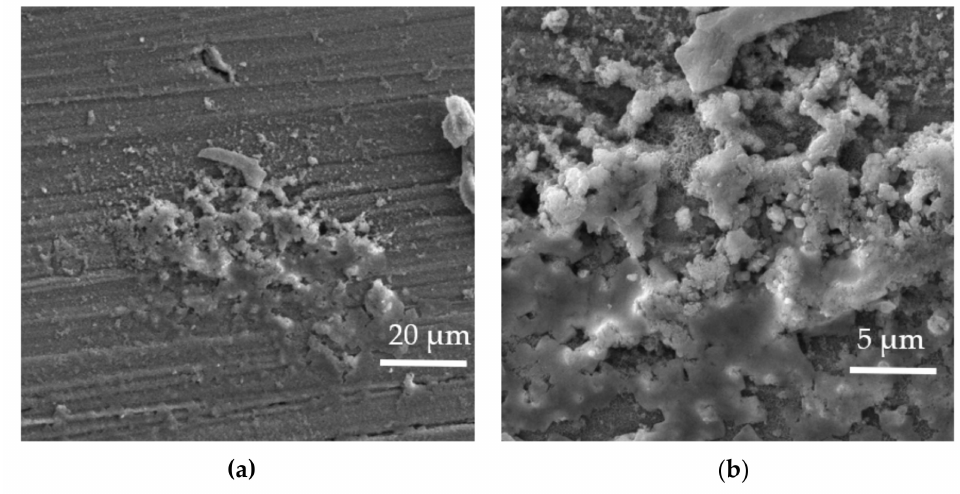
Figure 9. SEM images of PEO coating degradation in 0.1 M NaCl after 24 h of exposure, ( a ) image of formed corrosion product, ( b ) detailed image of corrosion product defective